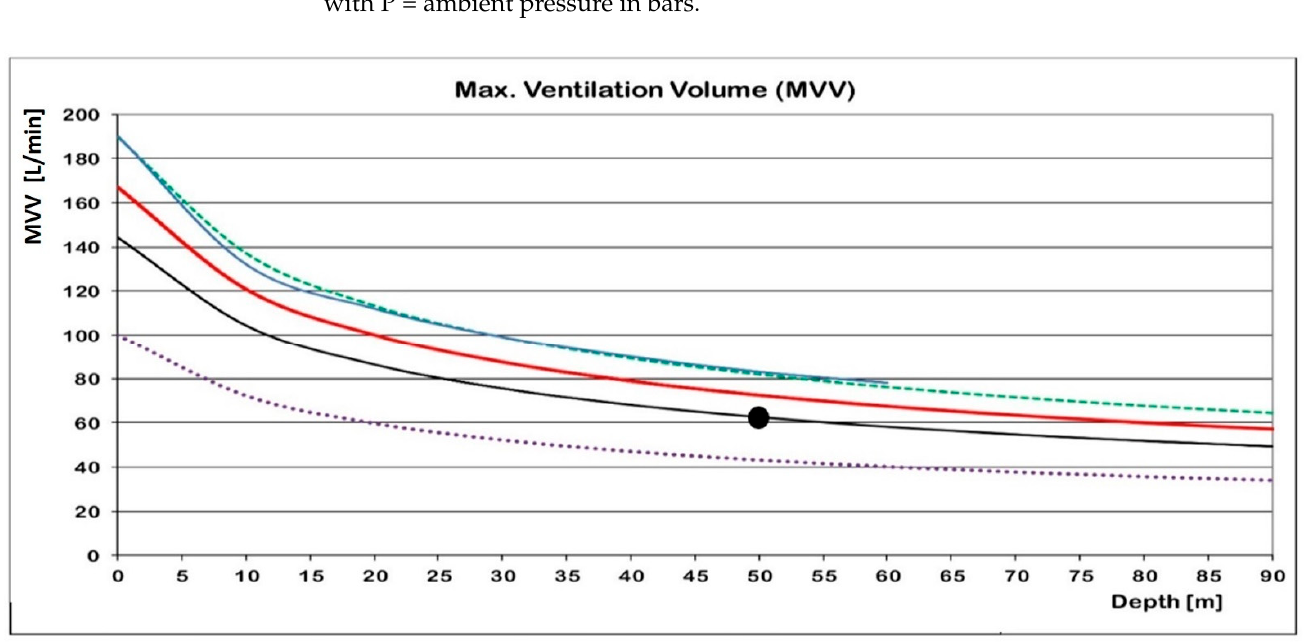
Figure 6. Dc’s maximum ventilation volume (MVV) with air as a function of depth (red). Similar curves are presented for untrained (dotted) and trained (dashed) divers [16], and for divers down to 60 m [17] (blue). The black line is extrapolated from a 50-m value contained in the ISO standards (EN 250) [18].